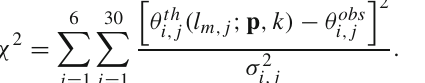
higher redshifts, reaching beyond feasible limits of super- nova studies ( z ∼ 1 . 4)